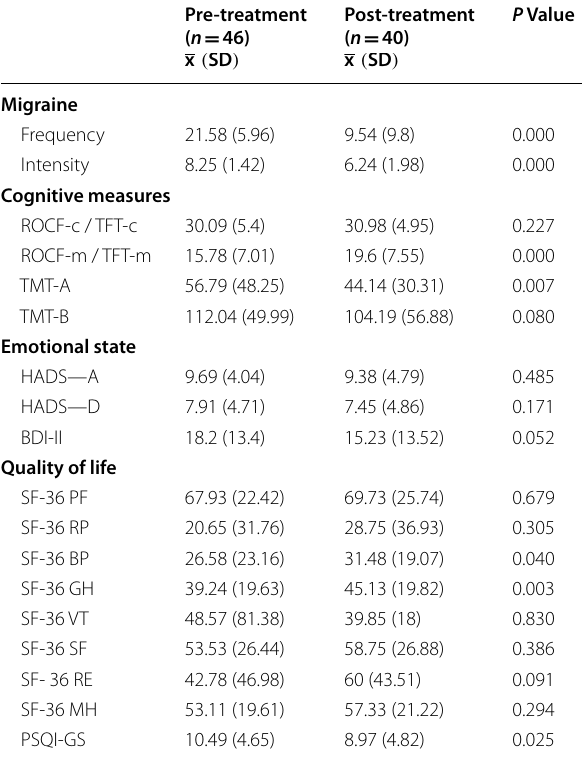
Table 3 Quality of life and cognition test scores before and three months after the start of preventive treatment in patients with CM